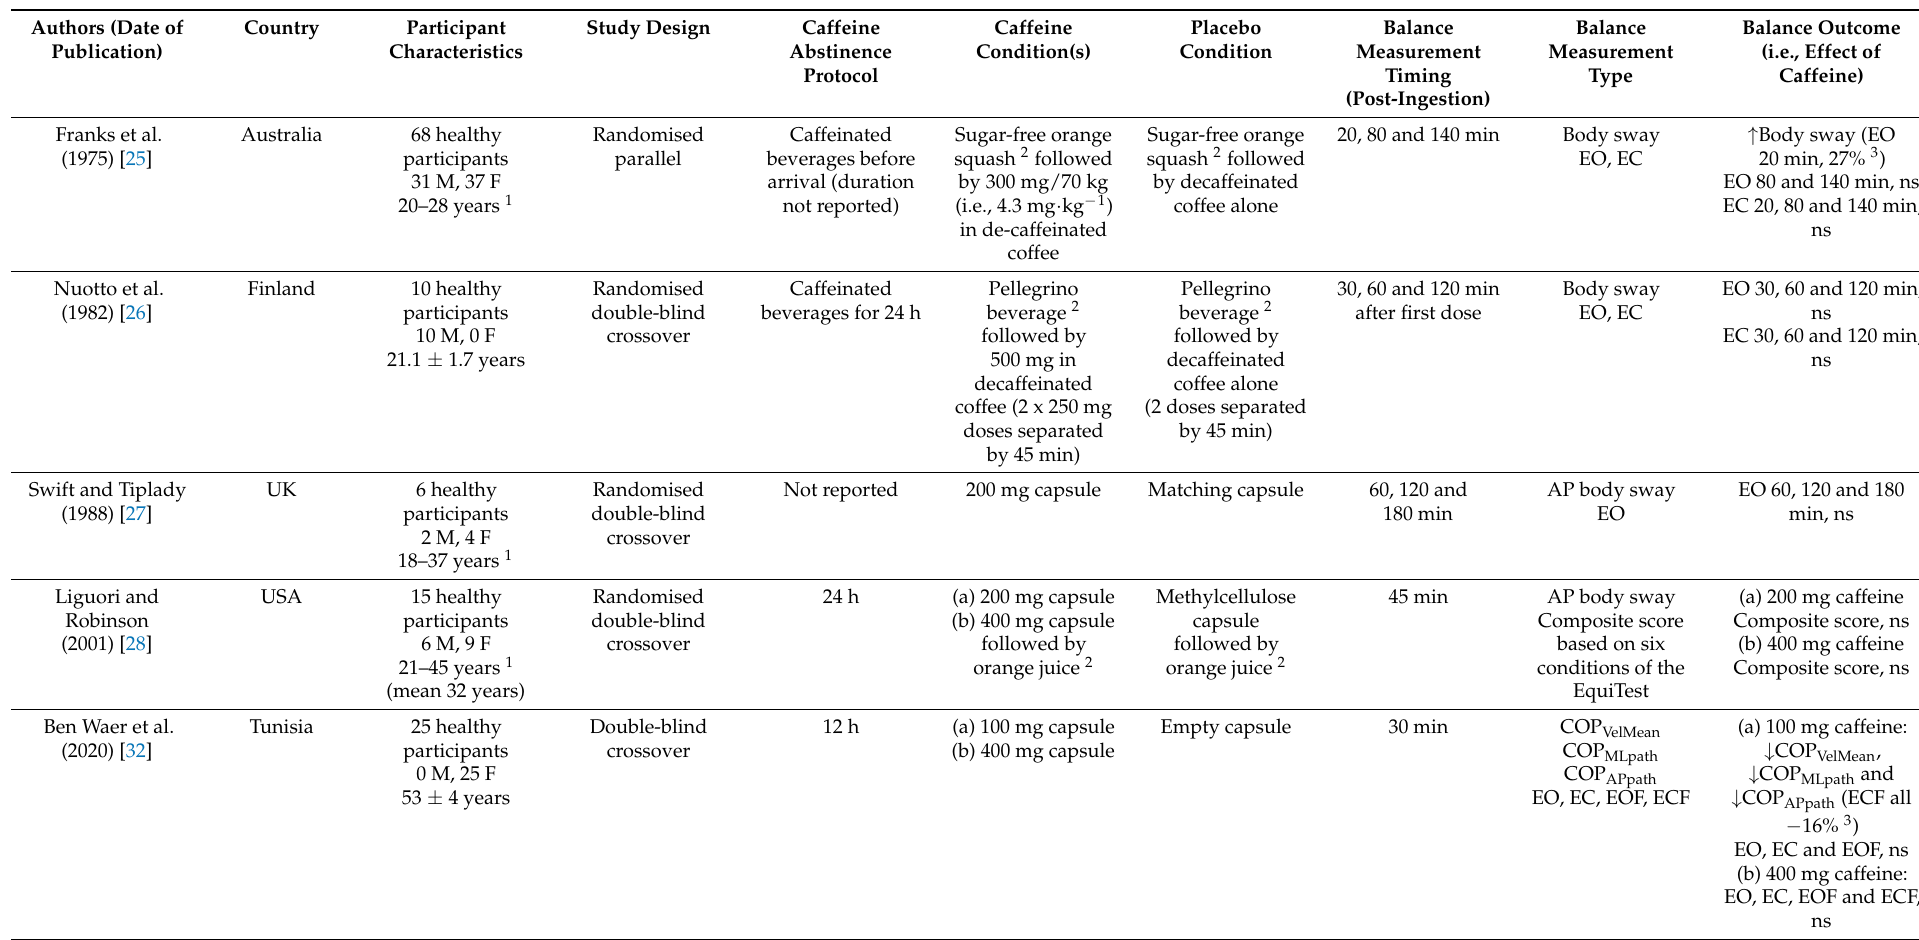
Table 4. Summary of the included studies with younger